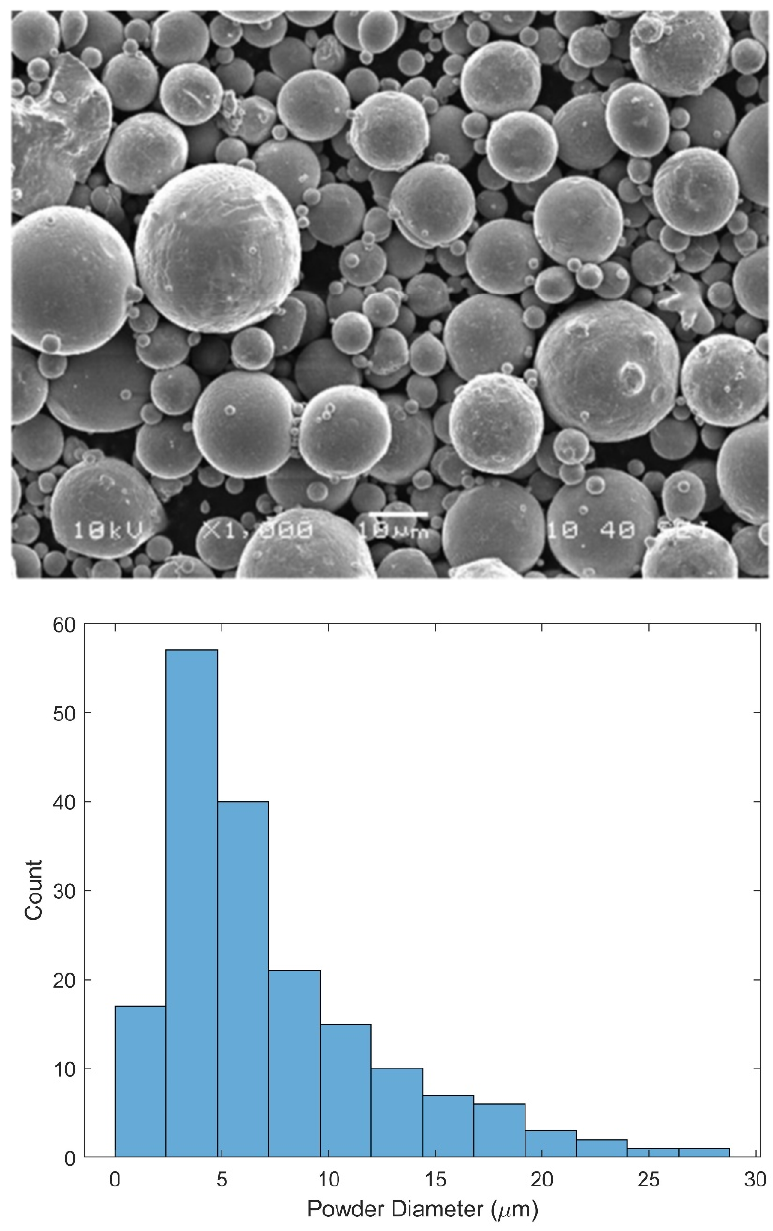
Figure 4. SEM photo of 316L powders (top ) [6] and powder size distribution ( bottom ).